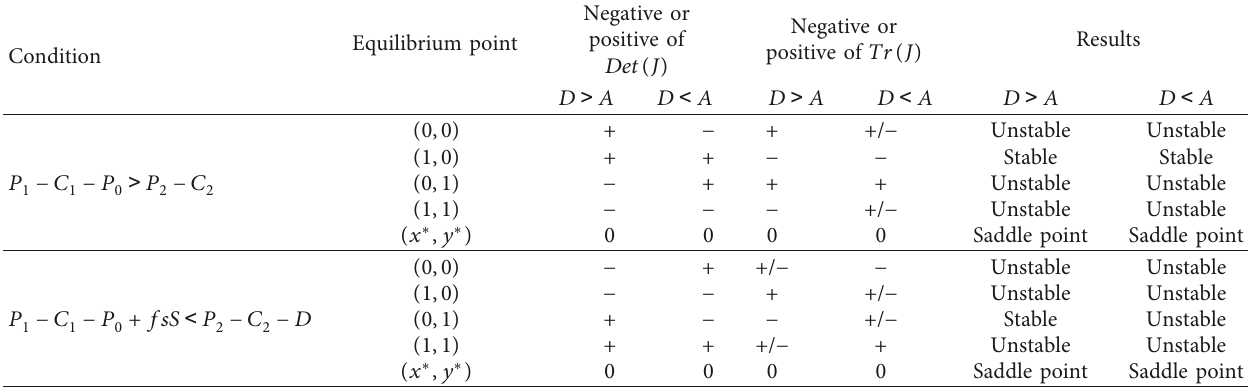
Table 5: Stability analysis results of local equilibrium